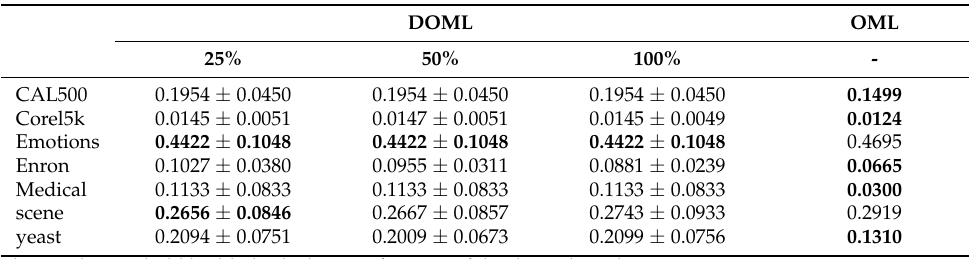
Table 6. Hamming loss of DOML in a 100-node network with different connectivity and OML with same amount of instances as each node.